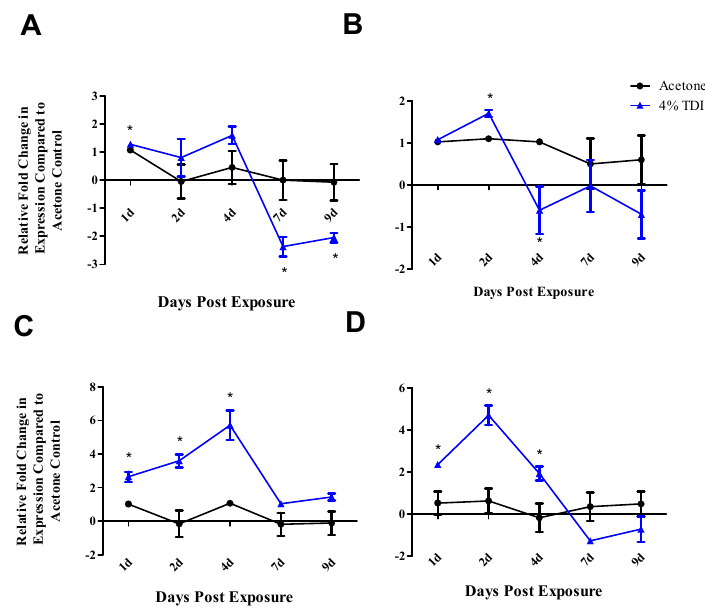
Figure 3. In vivo dLN mRNA expression of potential miR ‐ 210 targets reveals altered expression during TDI sensitization. RT ‐ PCR analysis of: foxp3 ( A ); runx3 ( B ); ctla4 ( C ); and cd25 ( D ) expression in the whole dLN at various time points post 0% and 4% TDI exposure. Bars represent mean relative fold change (± SE) of five mice per group. Statistical significance is represented by * ( p < 0.05) compared to the vehicle control.